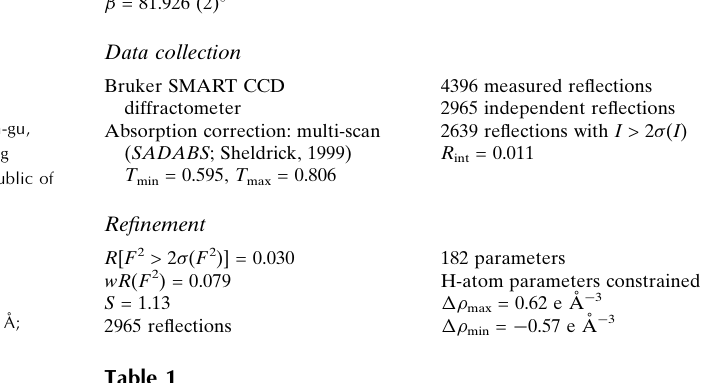
Hydrogen-bond geometry (A˚ , (cid:2) ). Cg is the centroid of the C2–C7 benzene